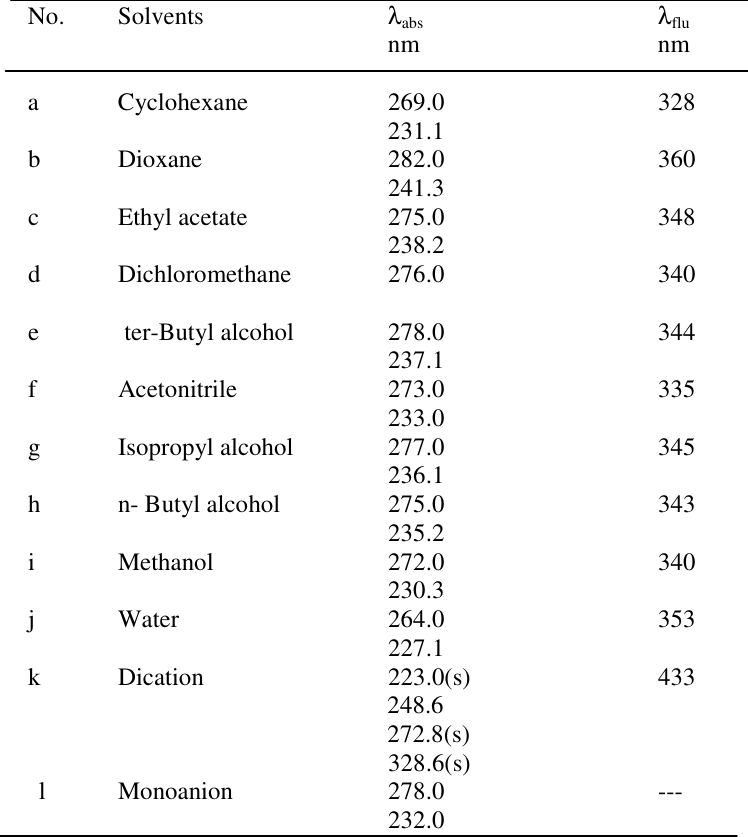
Table 1 . Absorption and fluorescence maxima of 1,5-Diaminoanthroquinone (DAAQ) in different solvents and various